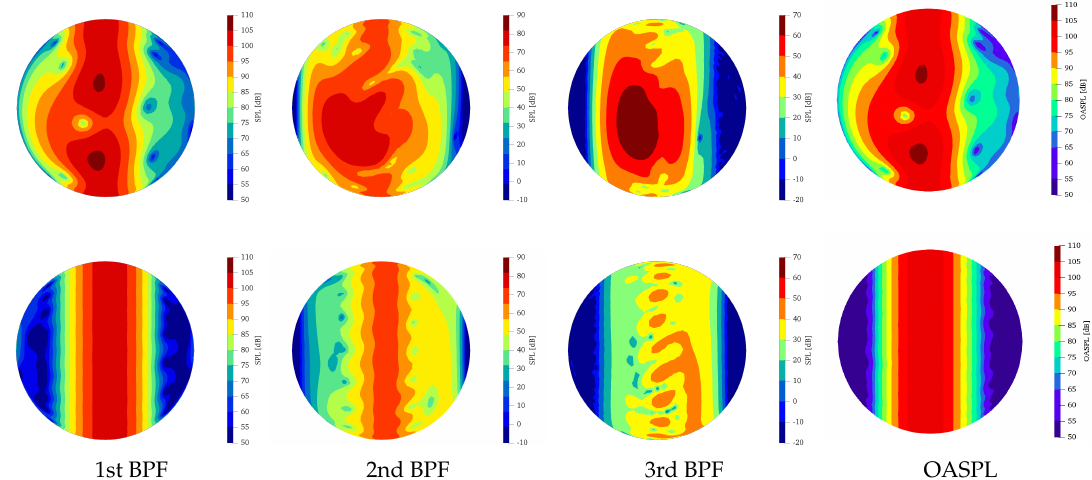
Figure 9. Sound directivity of rotor #1 for the case dist = 0 . The first row shows the noise sphere from below, the second one from above.